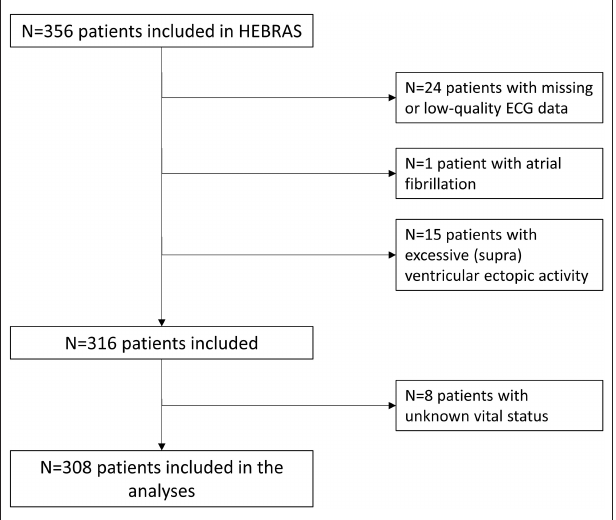
FIGURE 1 | Algorithm for inclusion/exclusion of